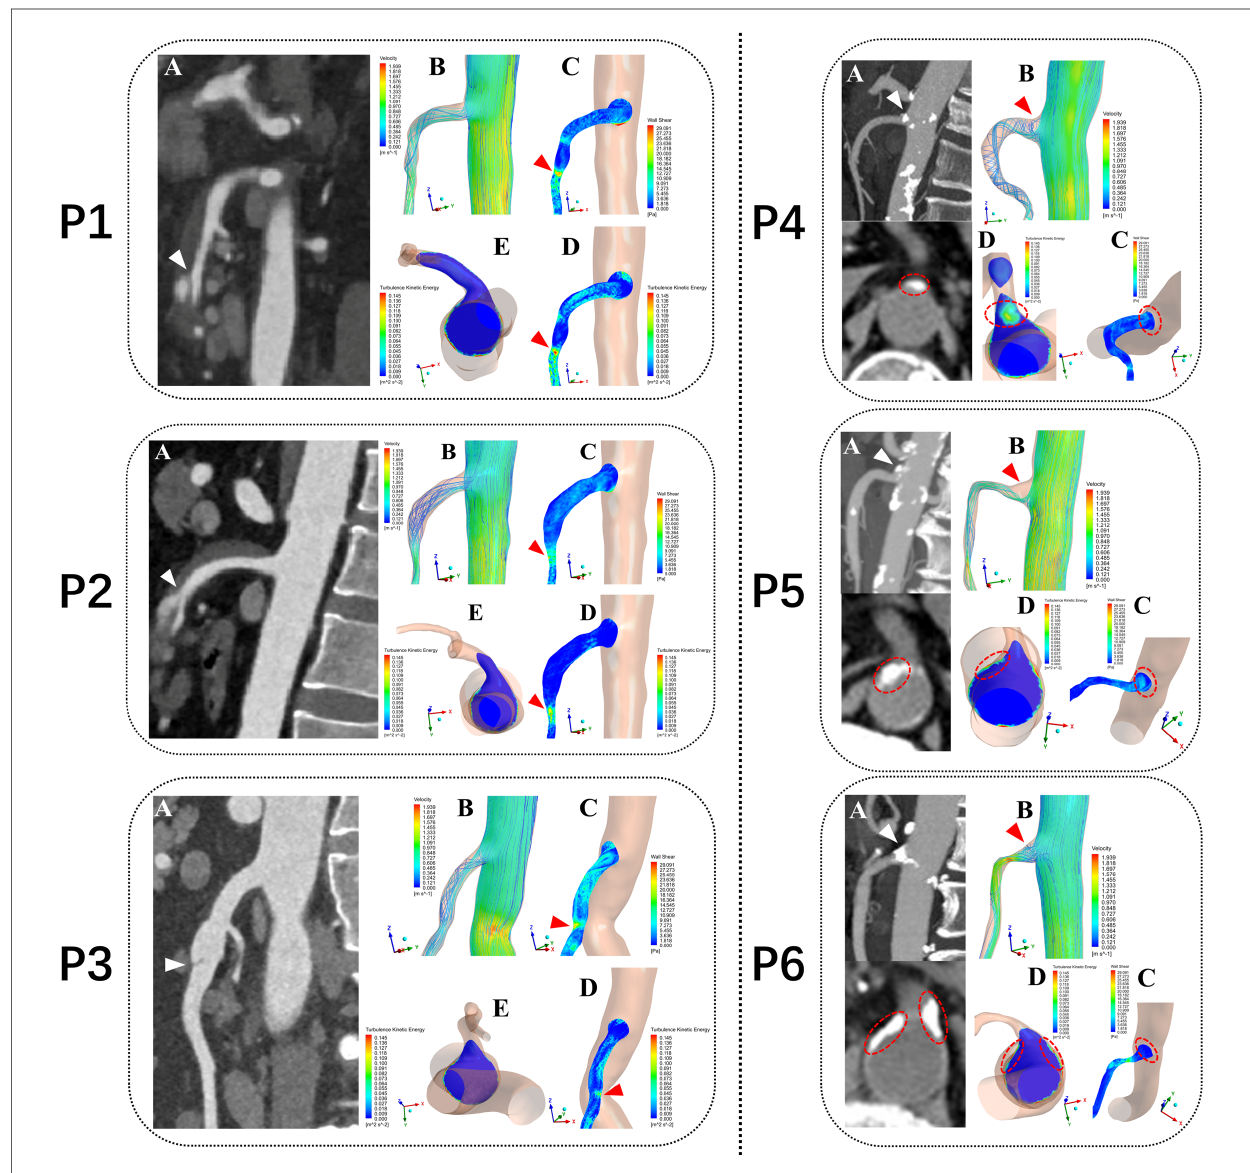
FIGURE 3 Computational fl uid dynamics simulation outcomes from six typical patients. P1, P2 and P3 represent three patients with superior mesenteric artery dissection (SMAD), P4, P5 and P6 represent three patients with superior mesenteric atherosclerotic stenosis (SMAS). P1, P2 and P3: ( A ) Sagittal CT images showing location of the dissections (white arrows). P4, P5 and P6: ( A ) Sagittal and Axial CT images showing location of the plaques (white arrows). P1 – P6: ( B ) Blood fl ow velocity (BFV) pattern of the superior mesenteric artery (SMA). ( C ) Wall shear stress (WSS) distribution at the wall of the SMA. ( D,E ) Turbulent kinetic energy (TKE) distribution at the wall of the superior mesenteric artery (SMA) ( E in P1 – P3) and cross-sectional plane at the SMA root ( E in P1 – P3 and D in P4 – P6). red arrows and circles represent the hemodynamic abnormality